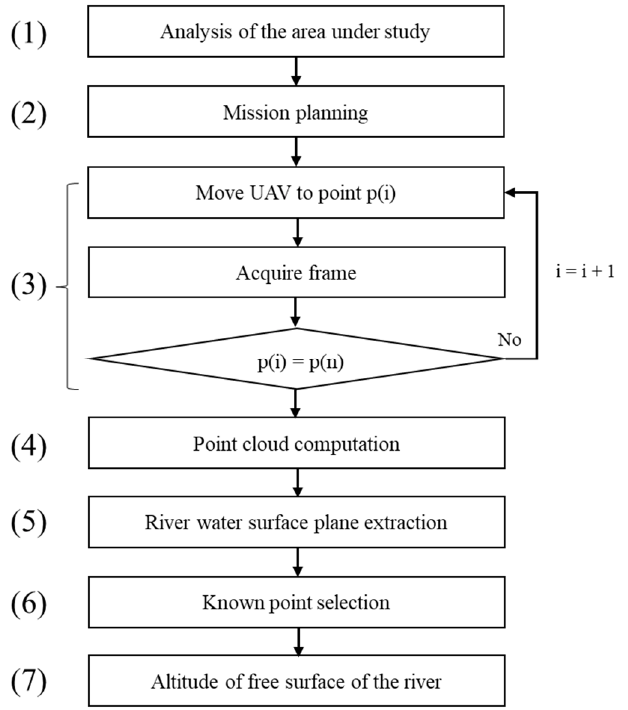
Figure 1. Workflow for determining altitude of the free surface of the river for aerial